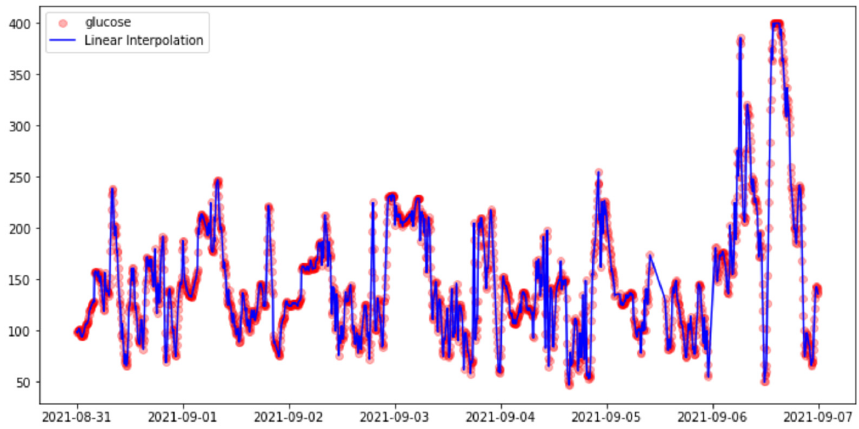
Figure 6. Comparing the true CGM time series with the imputed CGM using linear interpolation, in one week period for patient 588.